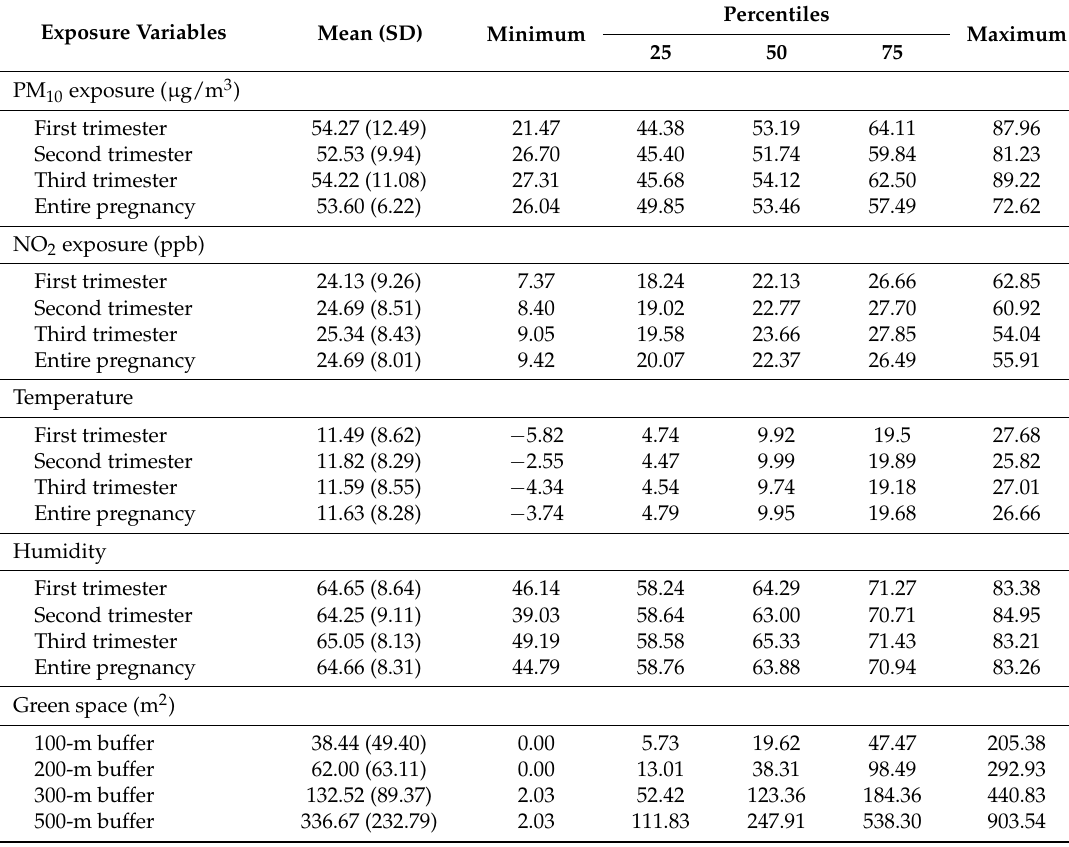
Table 2. Distributions of prenatal PM 10 /NO 2 exposure, temperature, humidity, and greenness levels in residential areas of 6-month-old